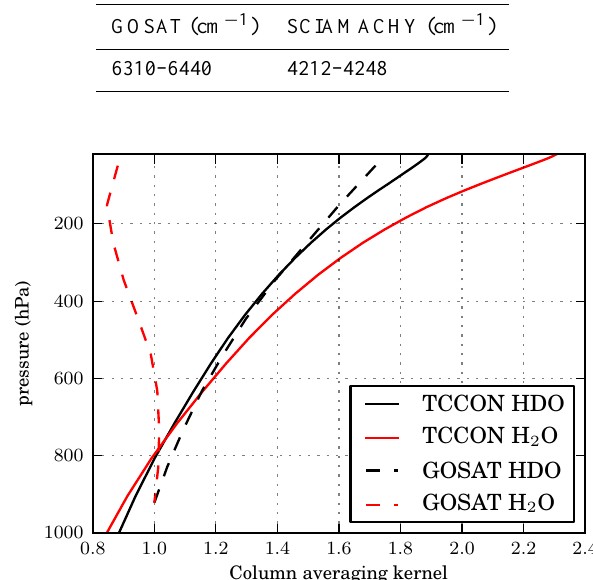
Fig. 4. Typical TCCON and GOSAT column averaging kernels for H 2 O and